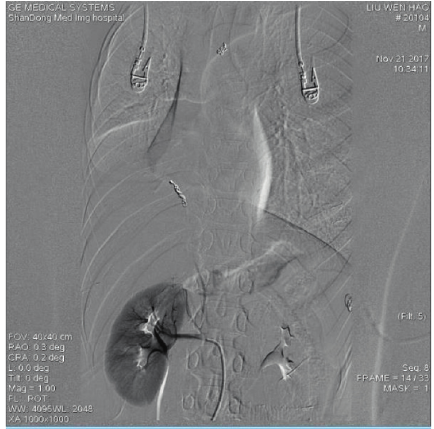
Figure 5: The end of the ectopic bronchial artery is blocked.